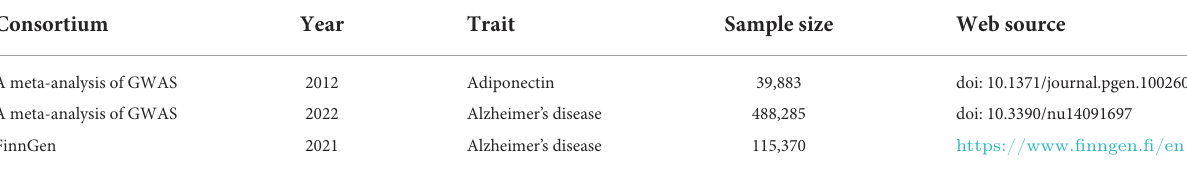
TABLE 1 Details of the GWAS included in the Mendelian